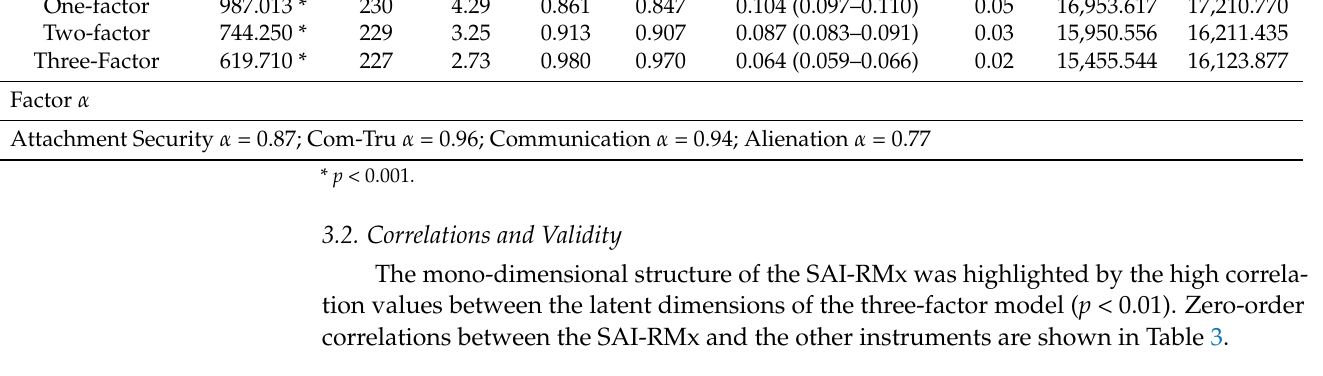
Table 3. Zero-order Correlations between the SAI, the IPPA (Parent Form), the LSRS, the SWLS, and the RSE ( N =